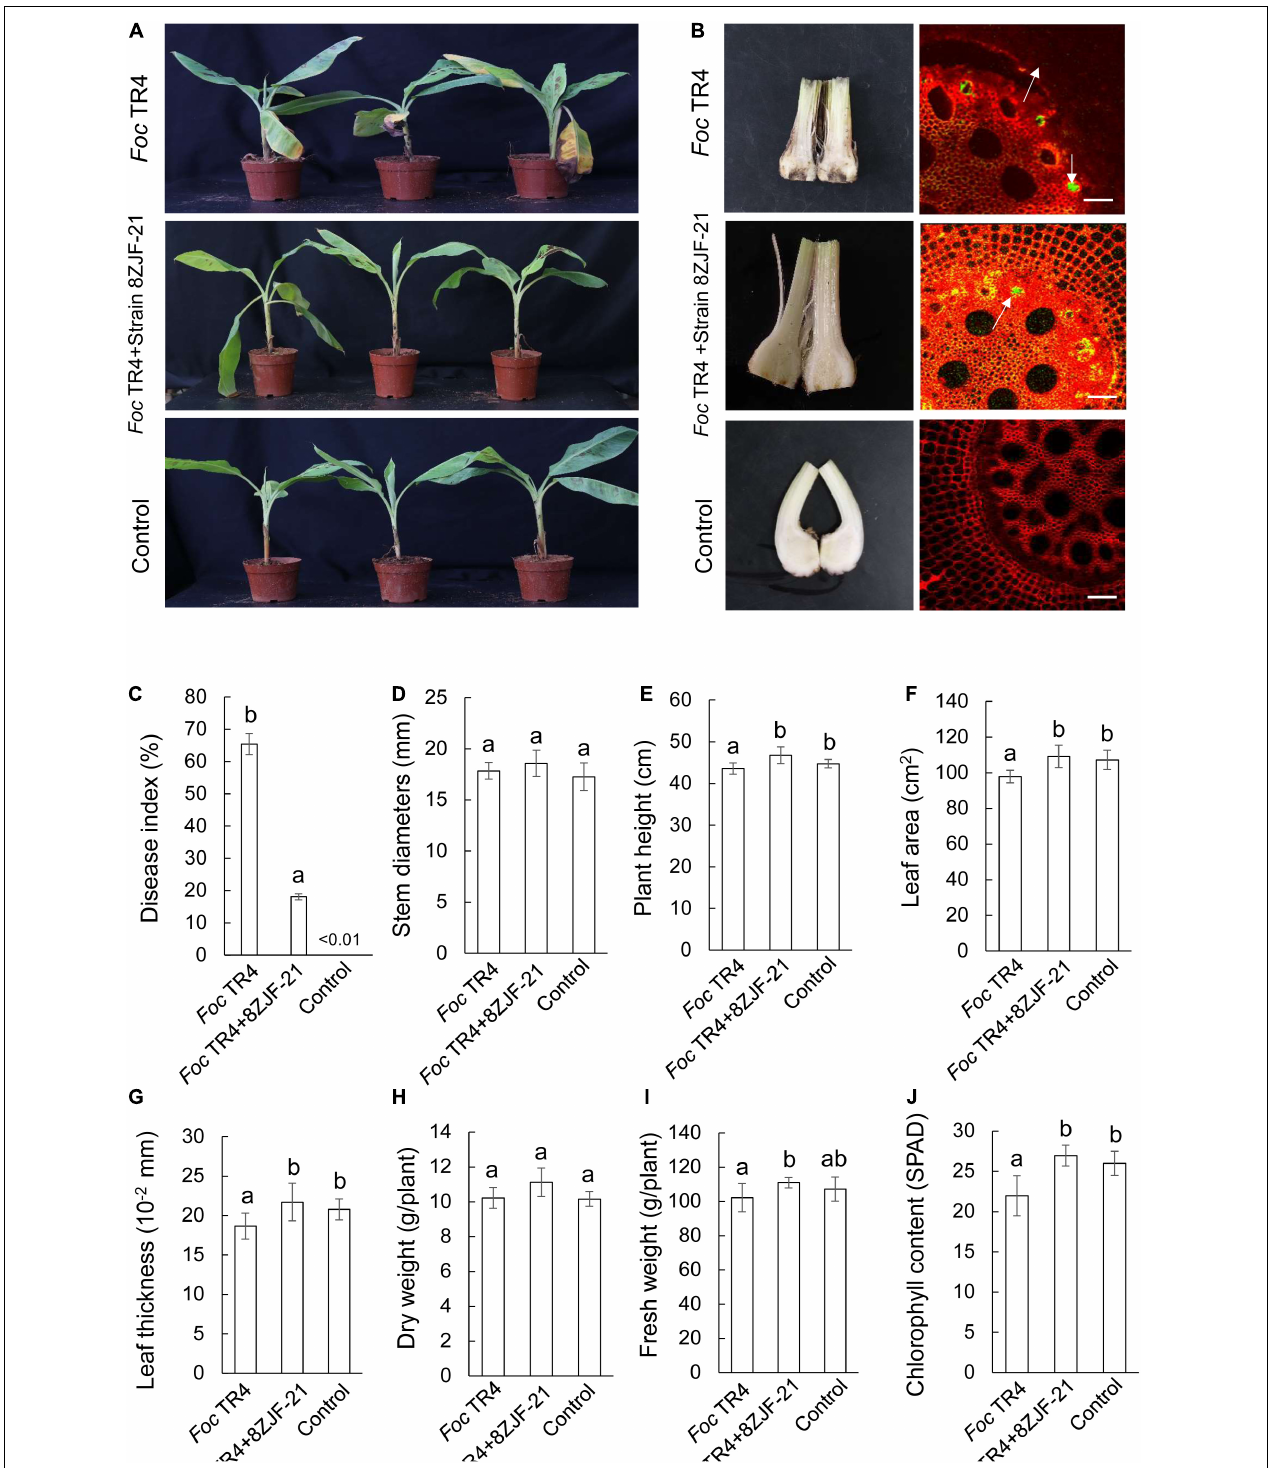
FIGURE 3 | Assay of Fusarium wilt disease control and plant-growth promoting after treatment with S. malaysiensis 8ZJF-21. (A) Chlorotic symptom of leaves in different treatment groups at 30 dpi. (B) Detection of Foc TR4 infection in the corm and root of banana seedlings at 30 dpi. (C) Quantitative analysis of disease index of banana seedlings at 30 dpi. Determination of physiological indicators including stem diameter (D) , plant height (E) , leaf area (F) , leaf thickness (G) , dry weight (H) , fresh weight (I) , and chlorophyll content (J) in different treatment groups at 30 dpi. Error bars indicate standard errors of the means from three repeated experiments. Different letters indicate a significant difference according to Duncan’s multiple range test ( P <